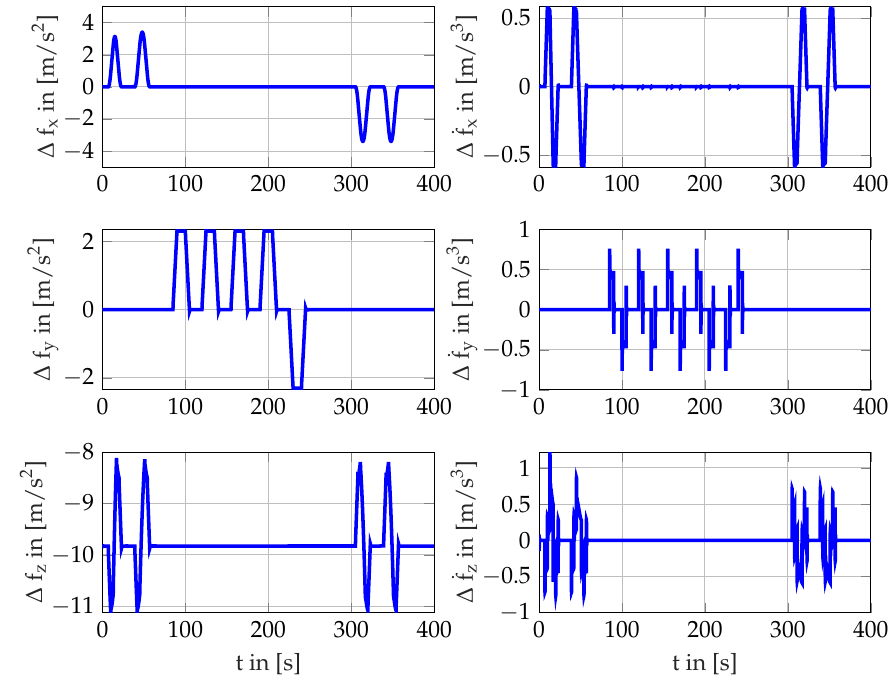
Figure 6. Specific force and its derivative along the